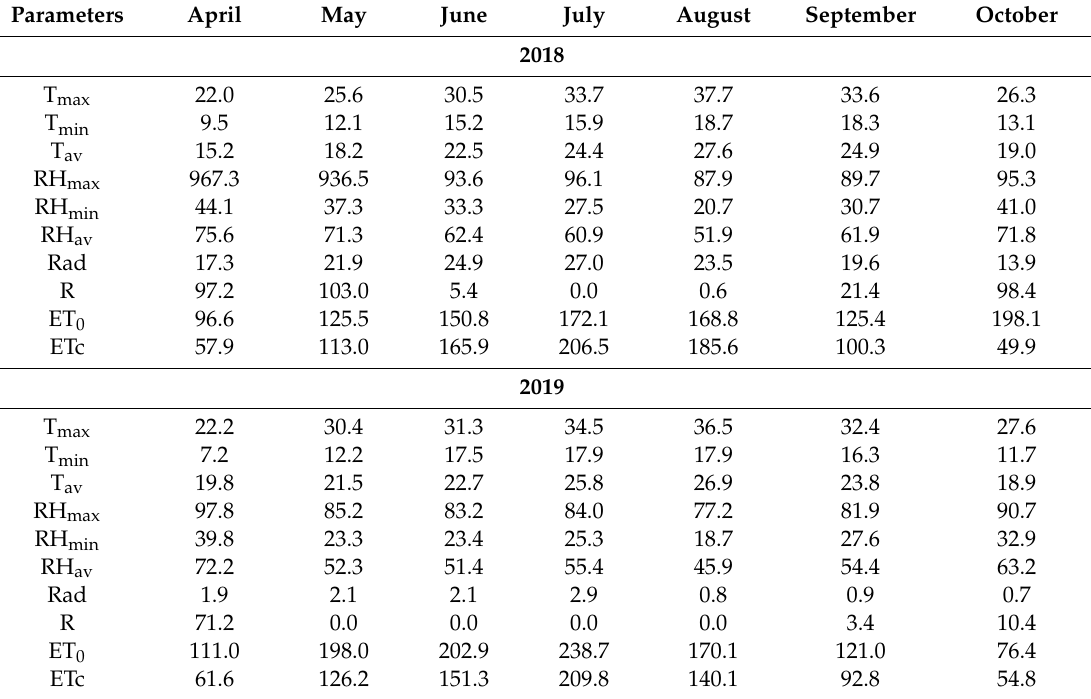
Table 2. Monthly average values of the weather parameters for the irrigation period during the study.